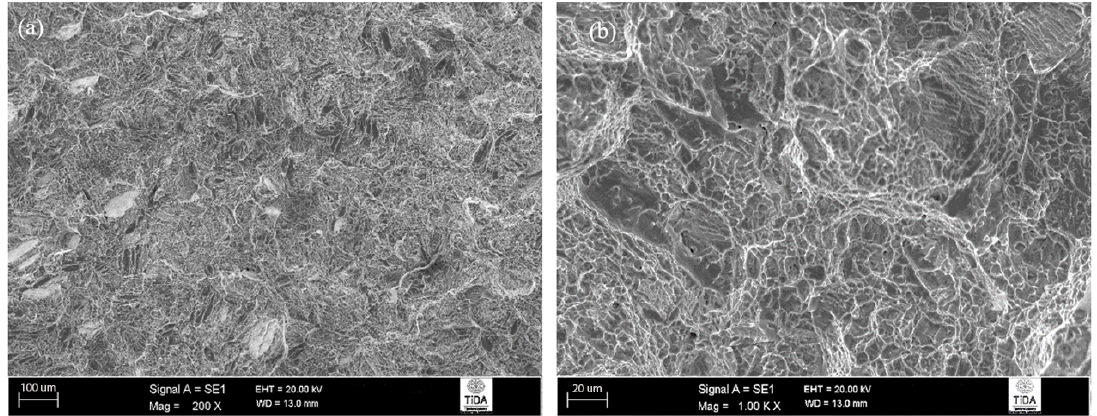
Figure 12. Fracture surface of 925 ◦ C / 4 h, CFC@50 ◦ C / h to 760 ◦ C, FC heat-treated Ti-6Al-4V alloy: ( a ) general appearance and the occasional presence of cleavage facets; ( b ) ductile dimpling.